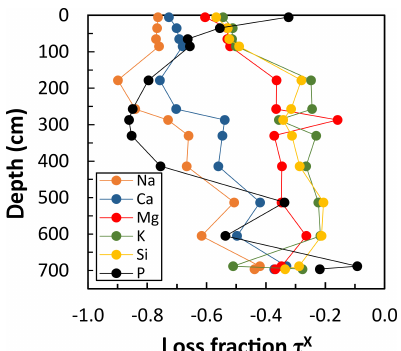
Figure 7. Elemental loss fraction (mass transfer coefficient) ( τ X ) Zr for macronutrients, the plant essential element Si and Na of the soil– saprolite depth profile BP. A τ X value <0 indicates elemental loss Zr in soil/saprolite relative to unweathered